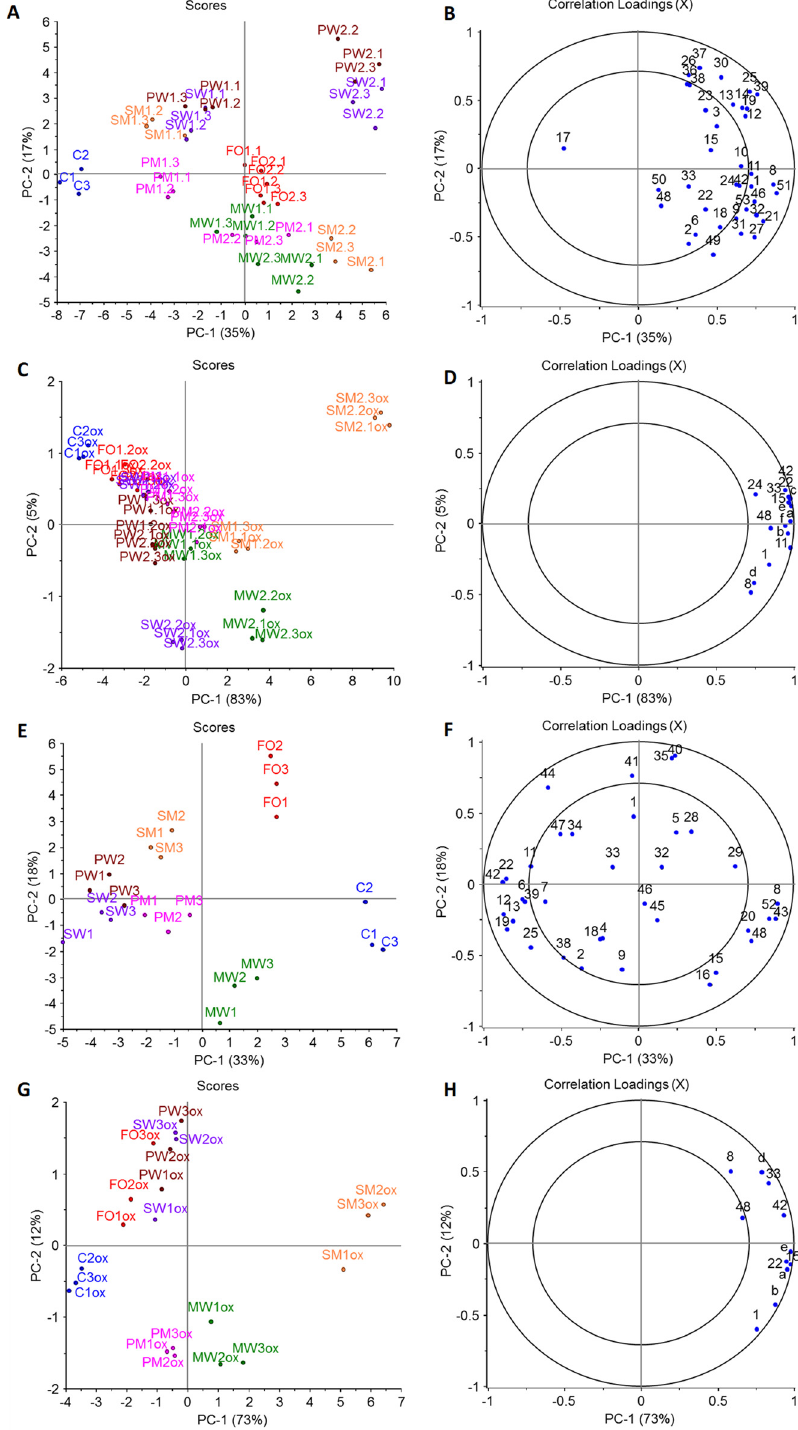
Figure 3. PCAs of identified volatile compounds in cookie ( A , B ) and chocolate ( E , F ) food model and PCAs of selected volatile oxidation indicators in stored cookie ( C , D ) and chocolate ( G , H ) food model (n = 3). In scores plots: C = control, FO = fortified with non-encapsulated fish oil, spray-dried emulsion with M = maltodextrin, W = WPC = whey protein concentrate, SF = sunflower protein, S = soy protein, or P = pea protein as wall material, first number indicates concentration (1 lower and 2 higher concentration of fish oil) and last replicate, ox = stored samples; in loading plots: 1 = acetal- dehyde, 2 = ethanol, 3 = propanal, 4 = methyl ester of acetic acid, 5 = 2-methylpropanal, 6 = 2,3- butandione, 7 = 2-butanone, 8 = acetic acid, 9 = 2,3-butanediol, 10 = 2-pentanone, 11 = pentanal, 12 =